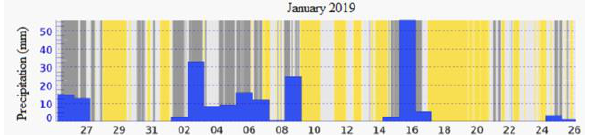
Figure 1. Adana monthly precipitation in January 2019